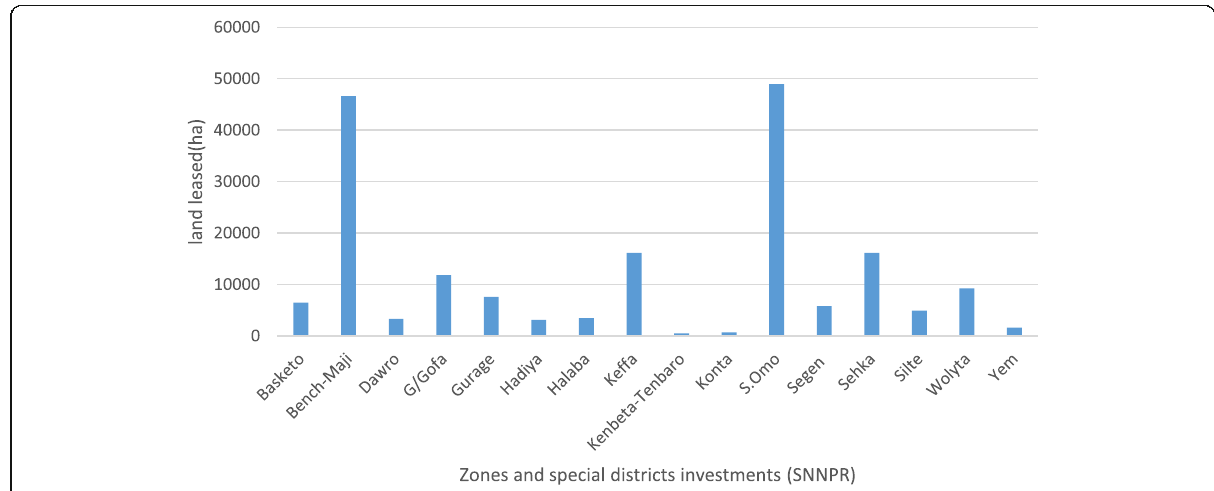
Fig. 5 Status of land leased in SNNPR (2006 – 2019, EIC) (note that the lands acquired by Omo-Kuraz I, II, III, and V are not included in this